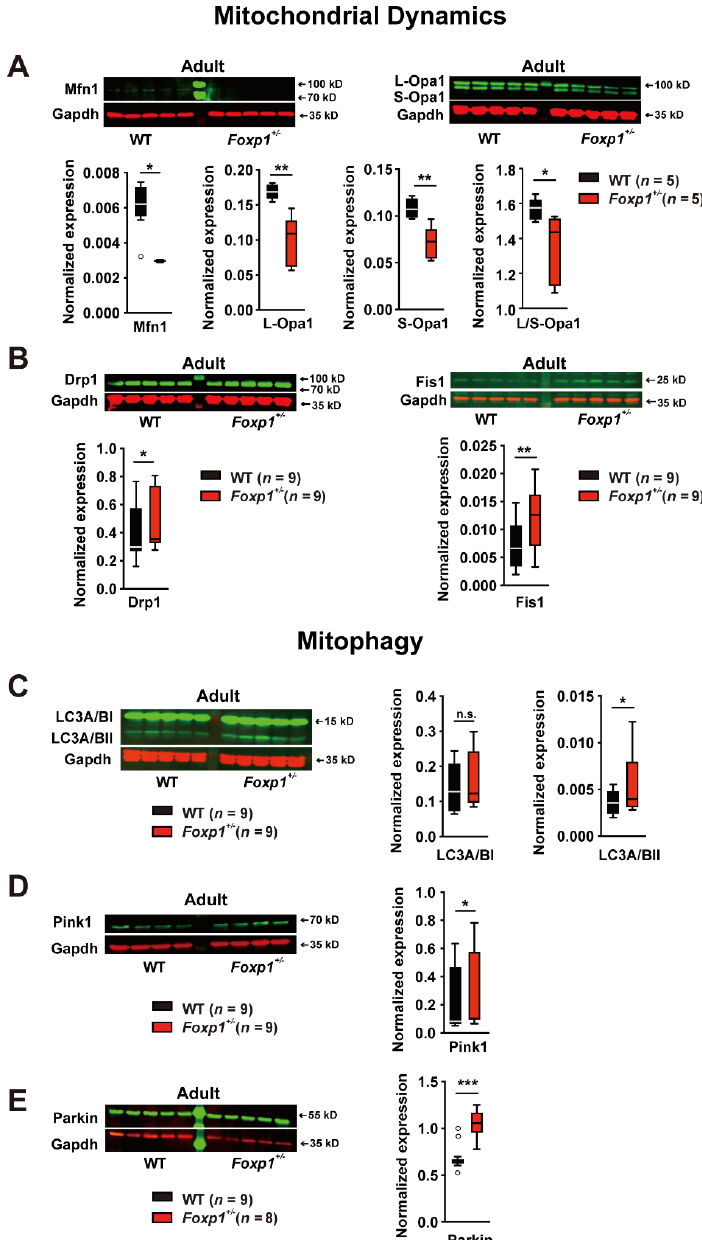
Figure 3. Altered mitochondrial dynamics and increased mitophagy in the adult Foxp1 +/ − hippocam- pus. Mfn1 and Long (L)/short (S)-Opa1 regulating the fusion of the outer and inner mitochondrial membranes, and Drp1 and Fis1 promoting fission were quantified in the adult WT and Foxp1 +/ − hippocampus by western blot ( A , B ). ( A ) Mfn1 was reduced by ~39% in Foxp1 +/ − tissue, and L-Opa1 and S-Opa1 levels were decreased by ~42% and ~35%, respectively, leading to a lowered L-Opa1/S- Opa1 ratio by ~14% suggesting impaired fusion. ( B ) Increased expression of Drp1 and Fis1 by ~20% and ~60%, respectively, points to elevated fission in the Foxp1 +/ − hippocampus. ( C ) To evaluate autophagy, LC3A/BI and LC3A/BII abundance was quantified by western blot. Increased LC3A/BI and LC3A/BII levels in Foxp1 +/ − tissue indicate an increased incidence of autophagy. ( D , E ) To inves- tigate mitophagy, Pink1 and Parkin levels were determined by western blot. Both Pink1 and Parkin expression were elevated in the Foxp1 +/ − hippocampus by ~31% ( D ) and by ~67% ( E ), respectively. The exact number of animals tested per group is indicated in the figure. Weak outliers are marked with a circle. Asterisks indicate a significant difference (* p ≤ 0.05, ** p ≤ 0.01, *** p ≤ 0.001); n.s. indicates non-significant; two-way